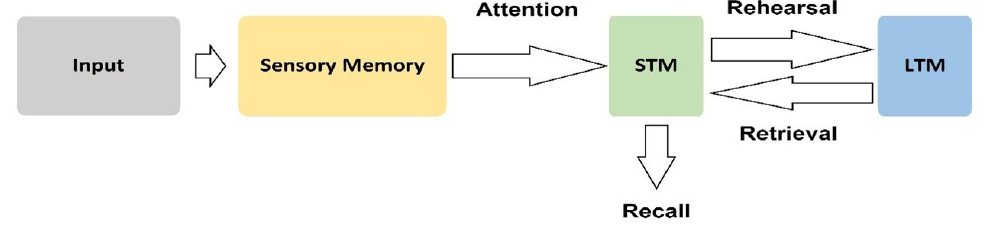
Figure 6. The information phases in the memory’s stages [164].